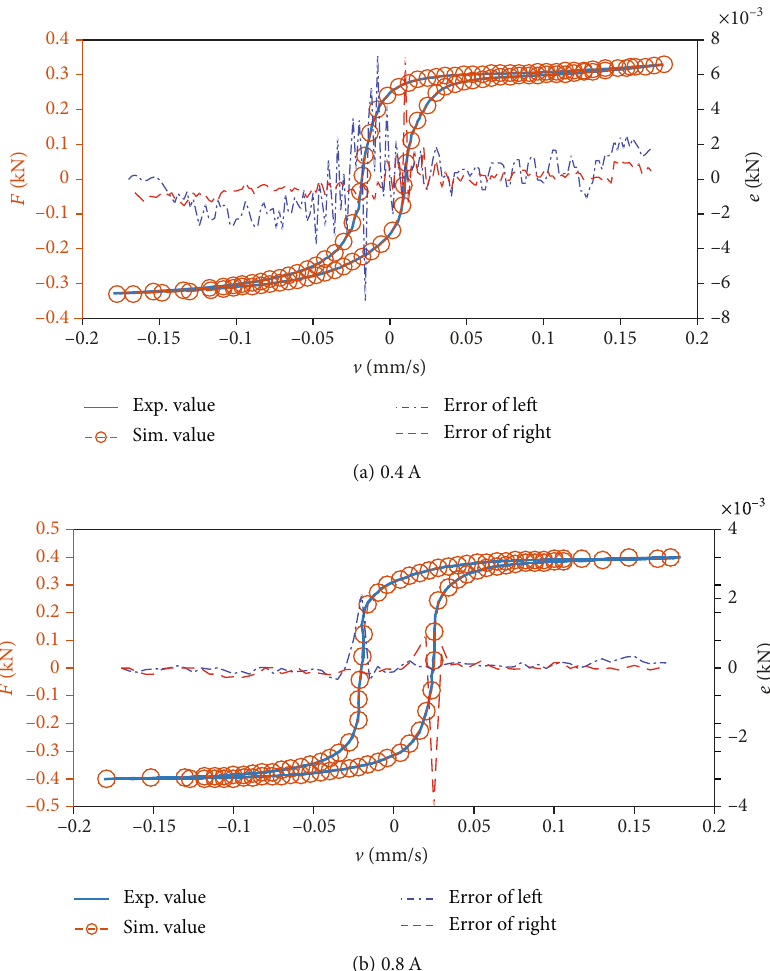
Figure 9: F - v comparison curves of di ff erent current values under excitation of 2Hz and